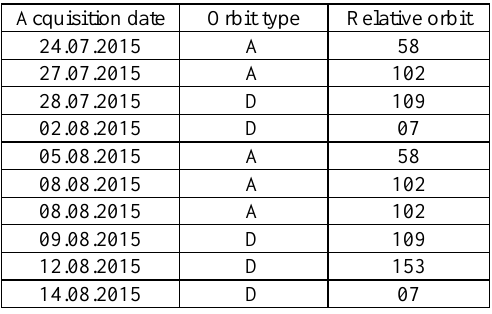
Figure 6. Giurgiu Harbour – 28.07.2015 - Sentinel-1A